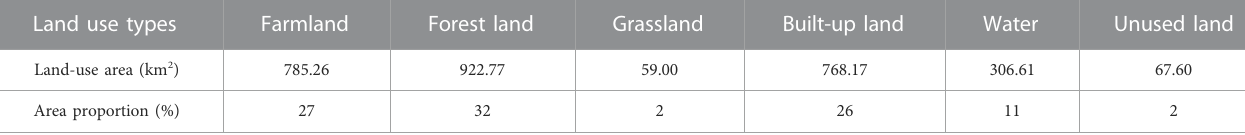
TABLE 1 Area of different categories of land use in Dianchi Lake basin in